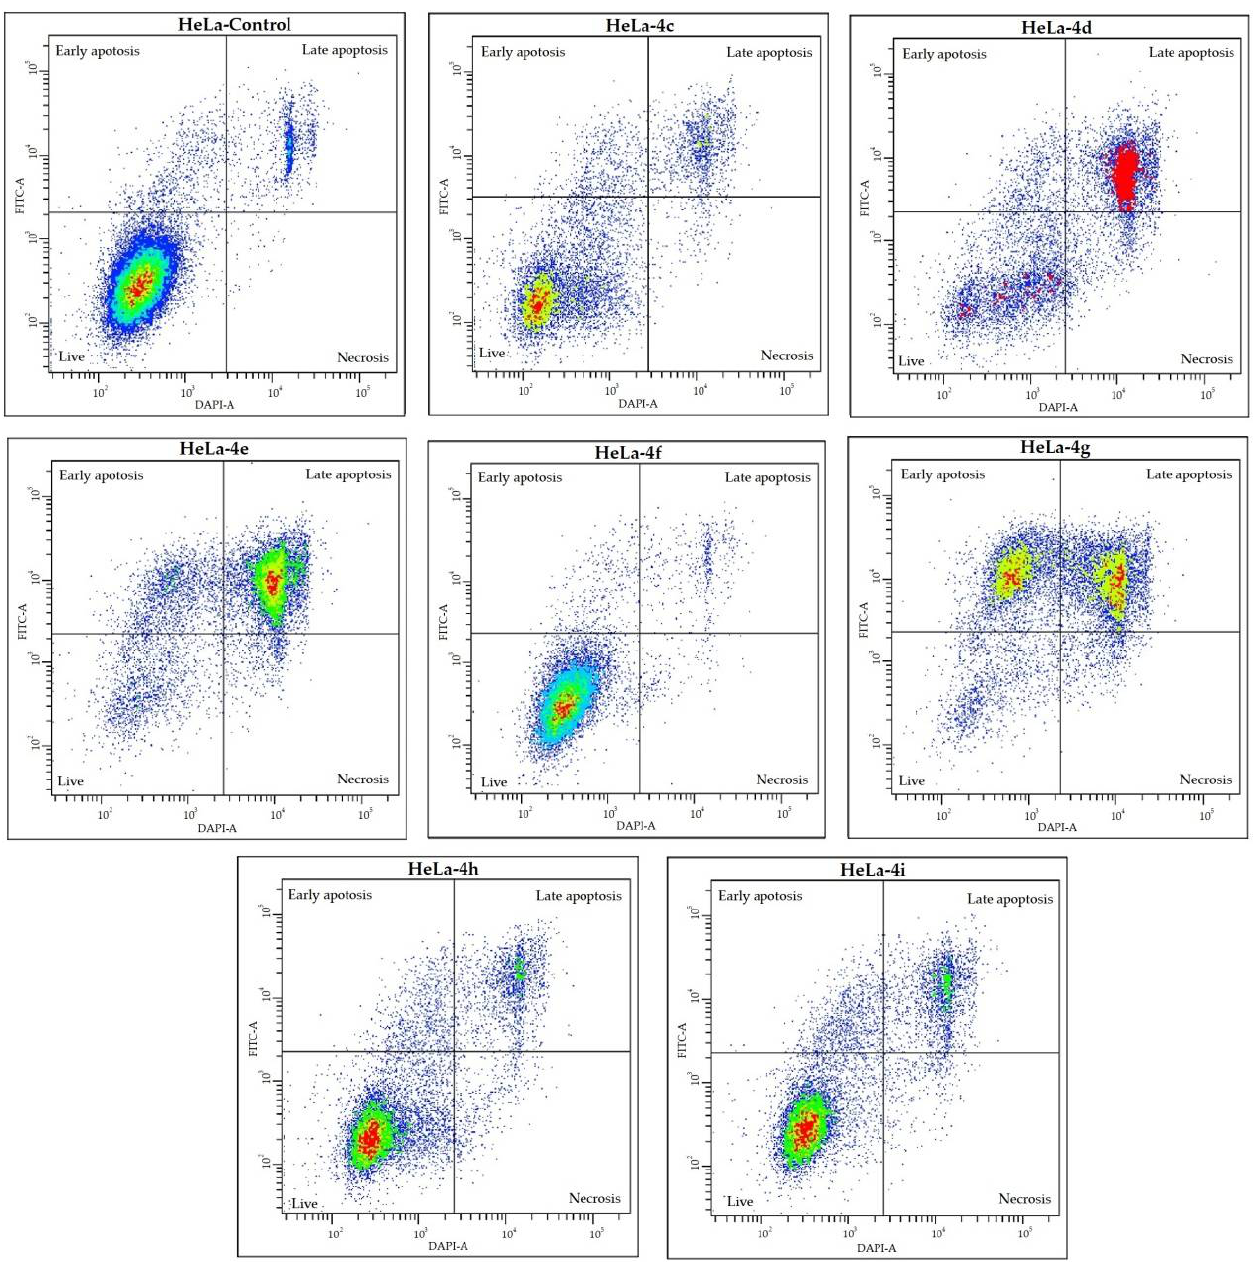
Figure 6. Apoptotic activity of HeLa cells treated with spiro-fused cycloadducts 4c – i at concentration 10 µ g/mL for 72 h using flow cytometry .